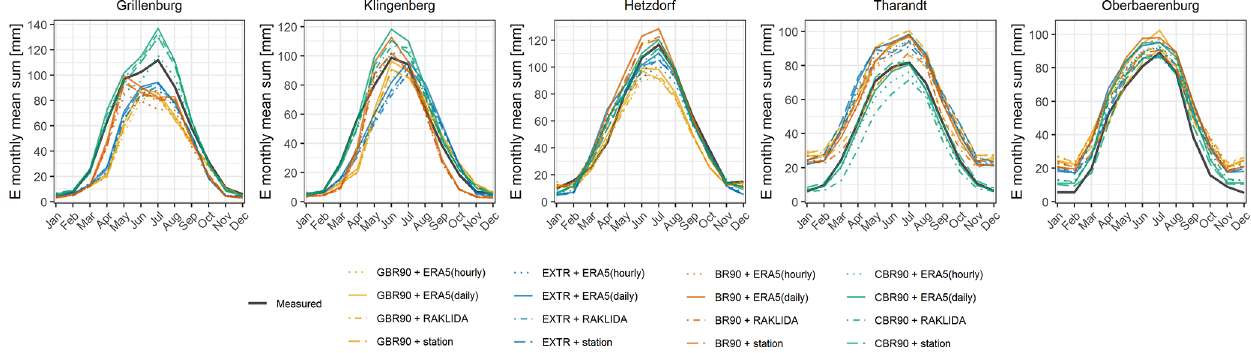
Figure 4. Observed and modelled monthly mean evaporation values for all